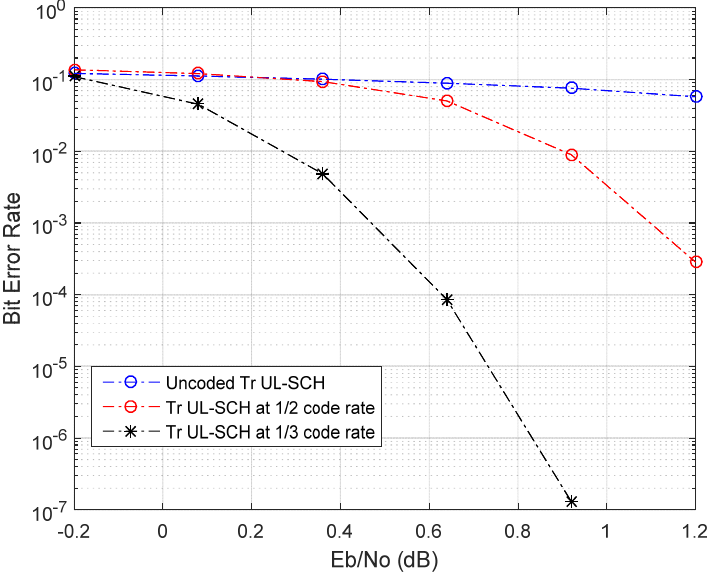
Figure 7. BER performance of Turbo decoding with different code rates.